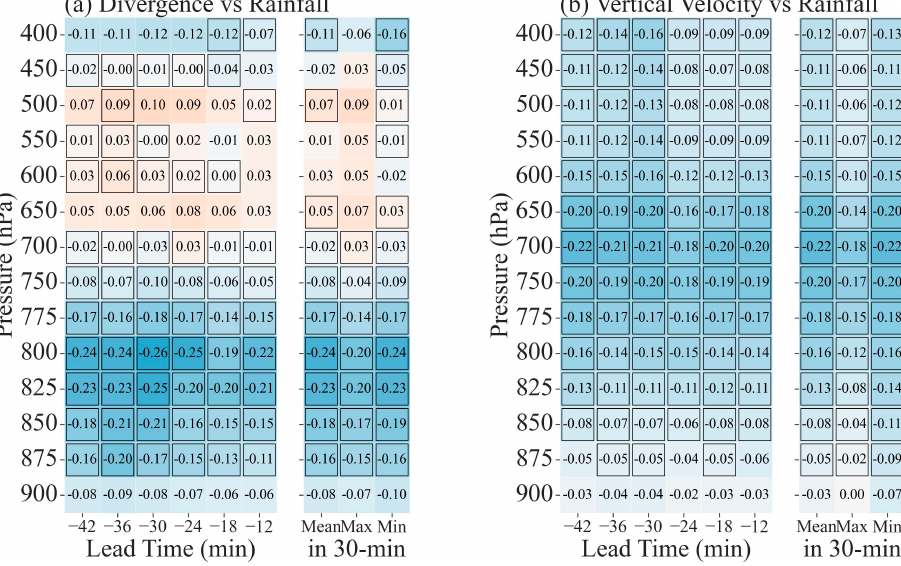
Figure 4. Time-lag correlation coe ffi cients between rainfall intensity and ( a ) divergence, ( b ) vertical velocity, and ( c ) vorticity (at 10-min intervals) retrieved from the RWP mesonet within 30 min before the onset of rainfall ( − 42– − 12 min). The black solid grid points represent statistical signi fi cance pass- ing the 99% con fi dence level.